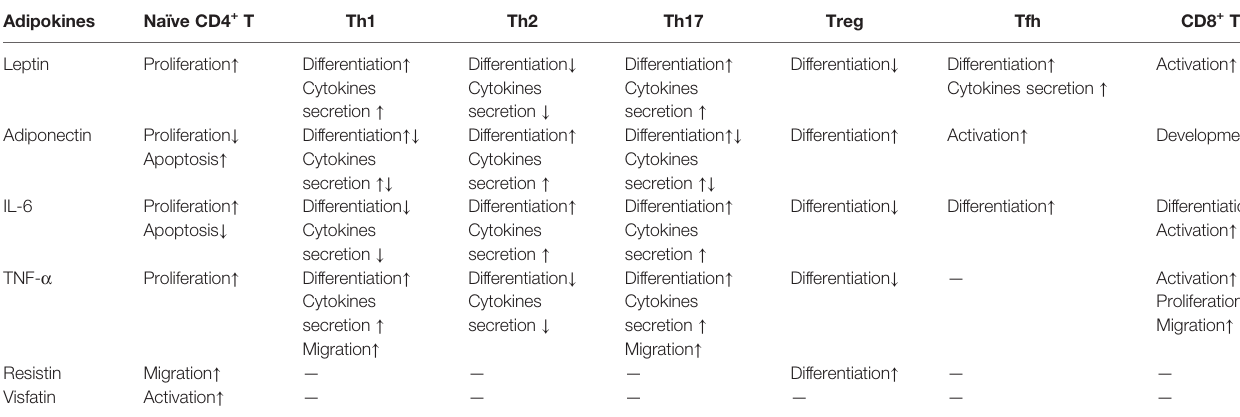
TABLE 1 | The effects of adipokines on T lymphocytes.